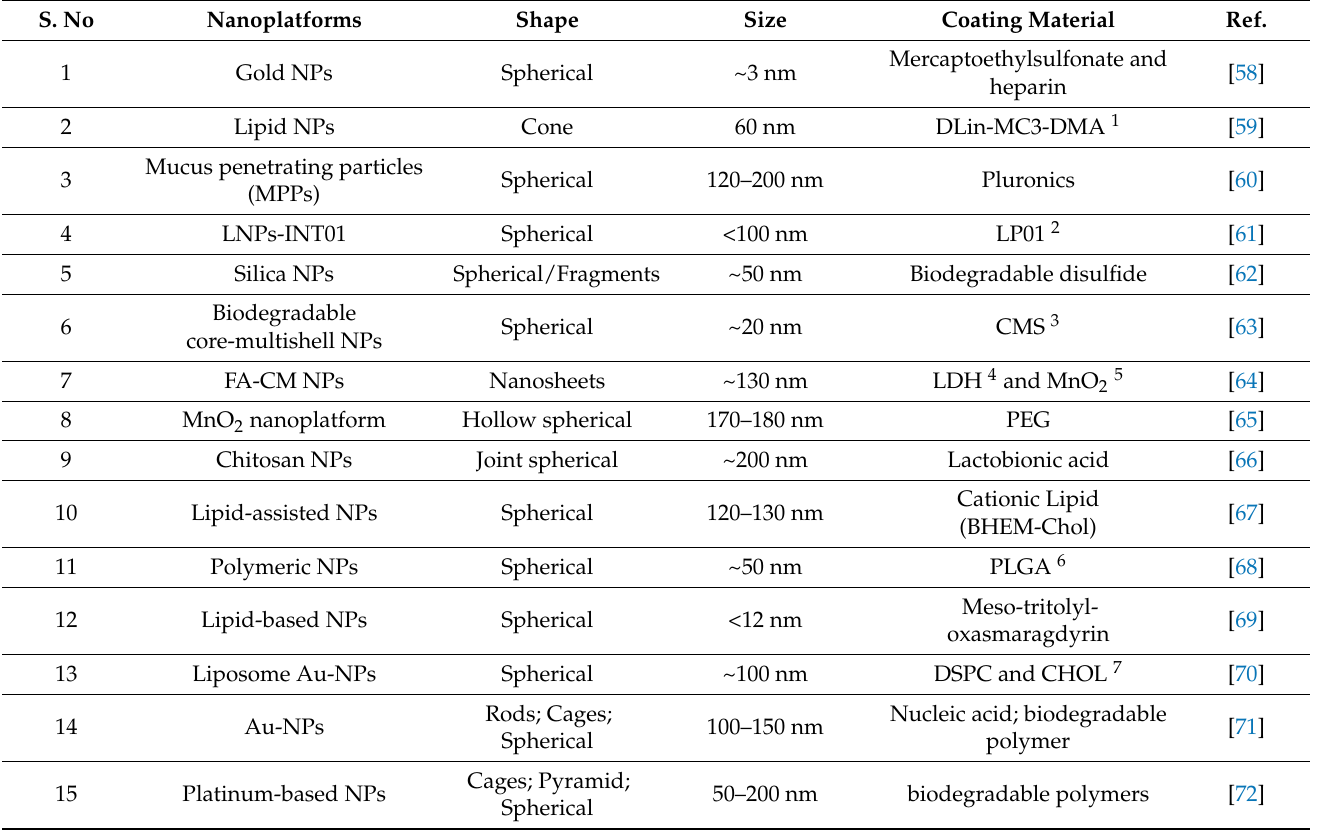
Table 1. Advanced nanoplatforms that are reported to be safe in different preclinical studies. In this table, we have covered the morphological characteristics of such nanoplatforms. The literature has reported a plethora of studies to demonstrate the safe and effective delivery of these nanocarriers; however, some of the recent examples have been